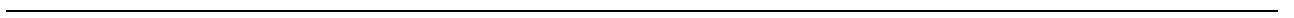
Fig. 2 Remodelin ameliorates cardiac and other pathologies of HGPS mice. Pathological staining in panels a – d was carried out on the materials from end- point mice (presented in Fig. 1f) of indicated genotypes ( n = 6 per genotype) treated with vehicle or Remodelin 100 mg per kg per day (for detailed ages